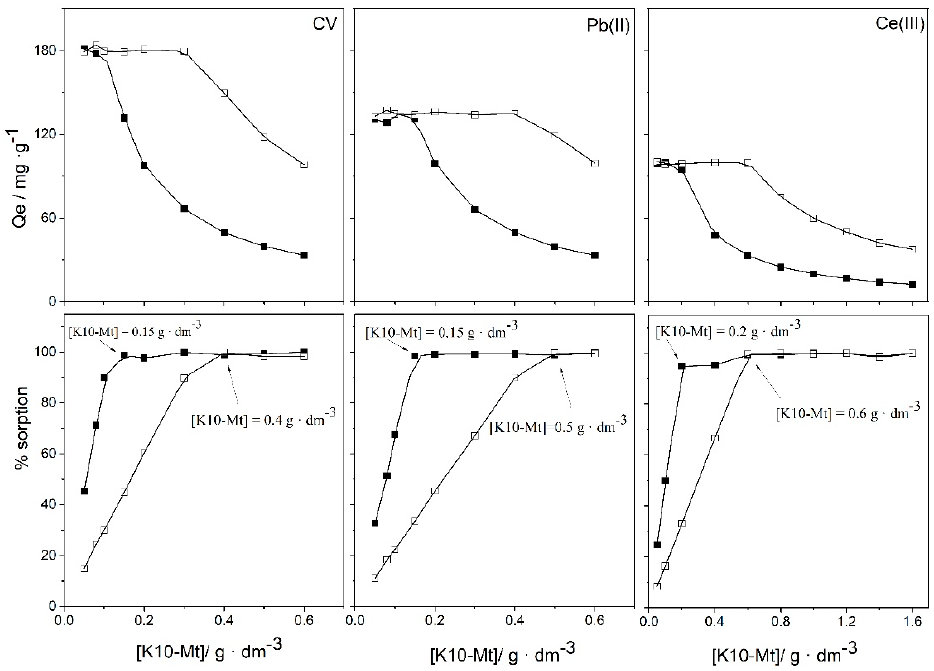
Figure 2. Sorption capacity of pollutants as a function of the amount of clay at pH 6.0. C 0 = 20 mg·dm − 3 ( ■ ) and C 0 = 60 mg·dm − 3 ( □ ). The amount of clay required for the complete adsorption of contaminants is indicated by the arrows in the graph.